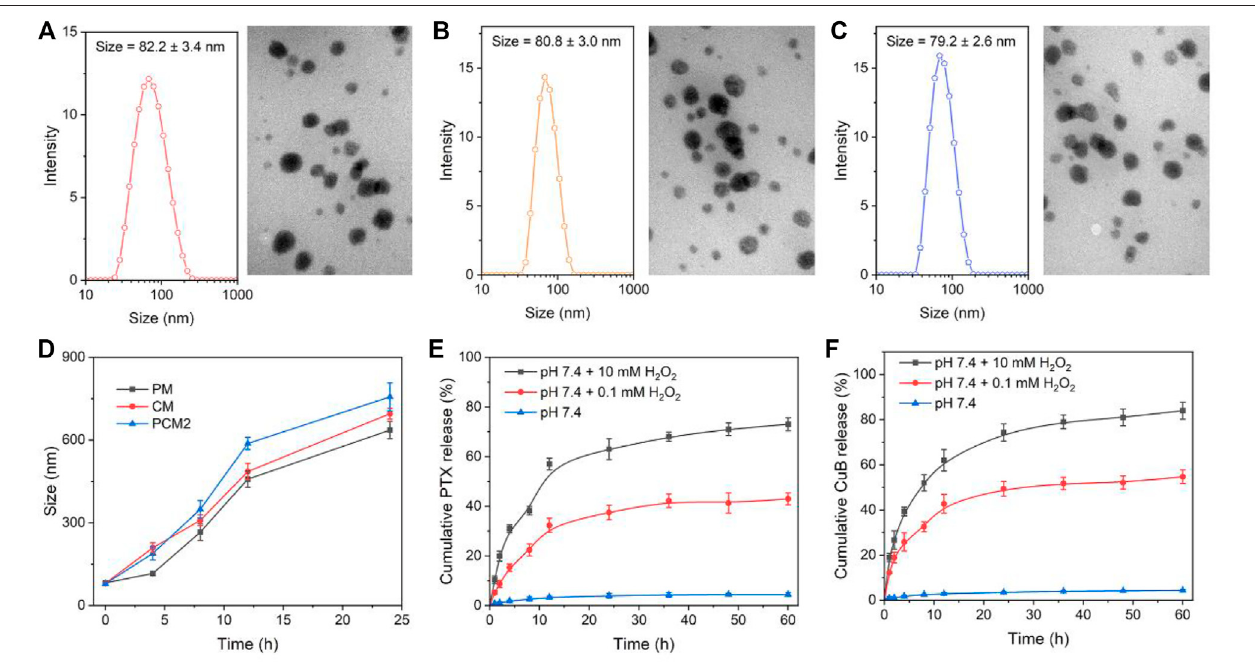
FIGURE 2 | Micelle characterization. (A – C) Size distribution and TEM images of PM (A) , CM (B) , and PCM2 (C) . (D) Changes in size of PM, CM, and PCM2 after treatmentwith10 mMH 2 O 2 for0,2,4,8,and16 h,respectively. (E,F) CumulativereleaseofPTX (E) andCuB (F) fromPCM2afterincubationwithvariousdoseofH 2 O 2 . The data in D, E, and F are presented as the mean ± SD, n =